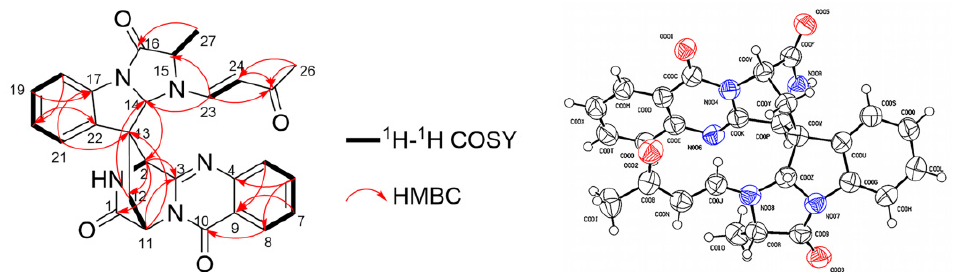
Figure 4. The key 1 H– 1 H COSY and HMBC correlations of compound 1 ( left ) and the X ‐ ray crystallographic structure of 1 (red circle: oxygen atom; blue circle: nitrogen atom) ( right ).